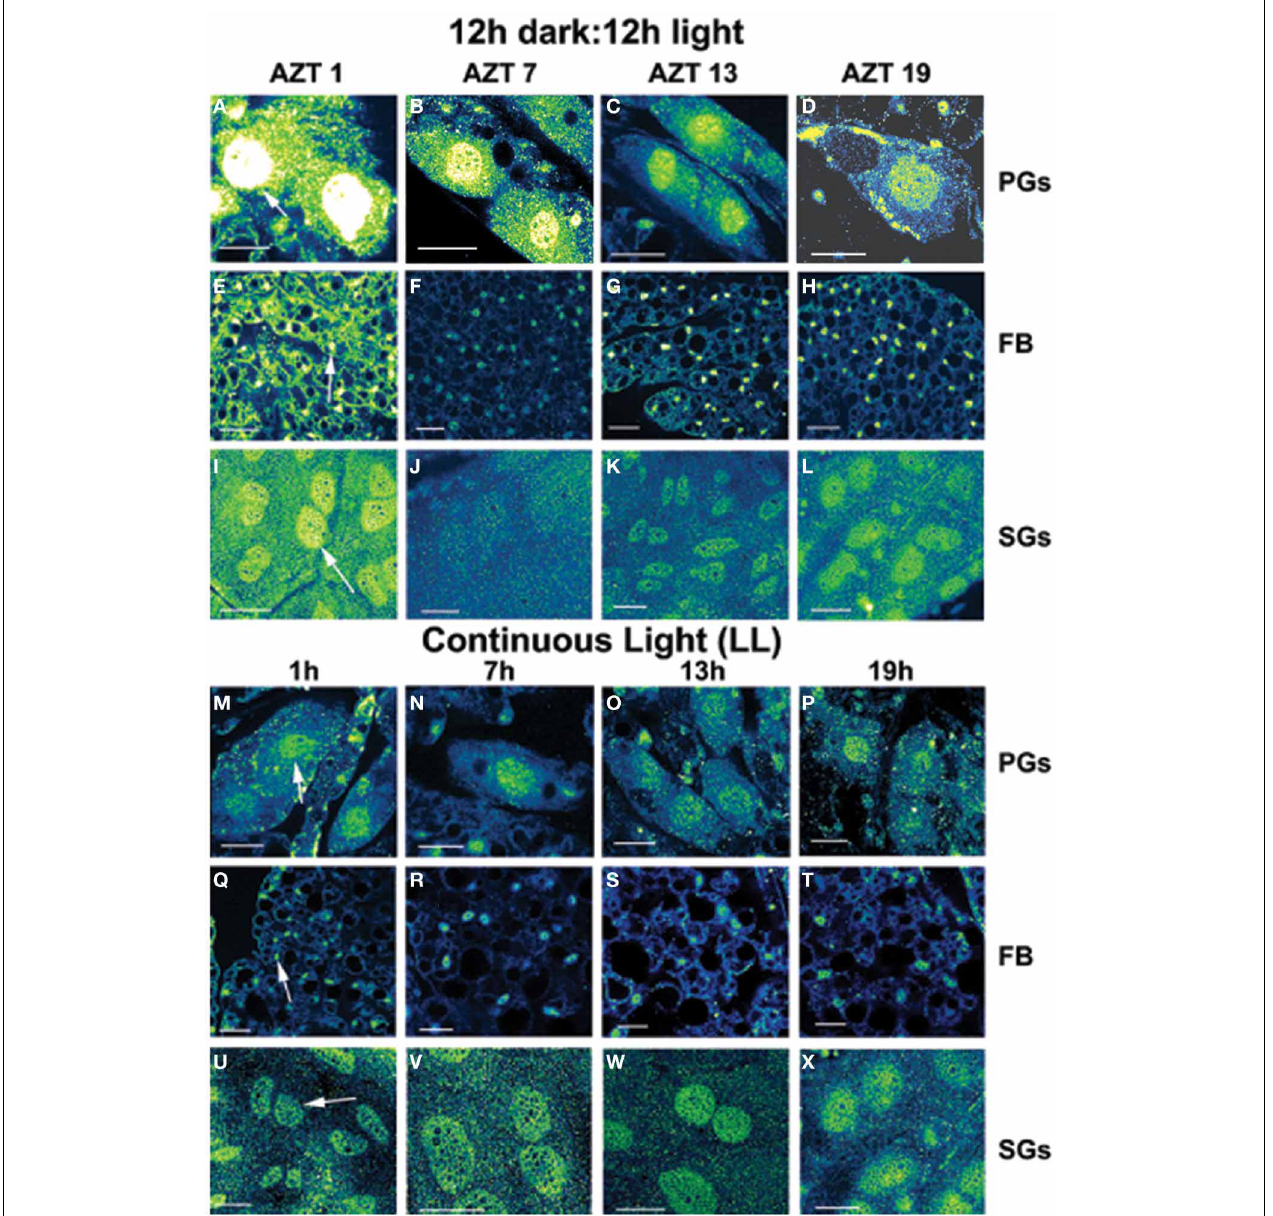
FIGURE 1 | Daily cycling in vivo in abundance and nuclear localization of PER immunofluorescence (A–L). Green/yellow/white shows fluorescence. Tissue samples were dissected at four times during day 12 after a blood meal: 1h after lights-off (AZT 1), 7h after lights-off (AZT 7), 1h after lights-on (AZT 13) and 7h after lights-on (AZT 19). (A–D) show PG cells, (E–H) show FB cells and